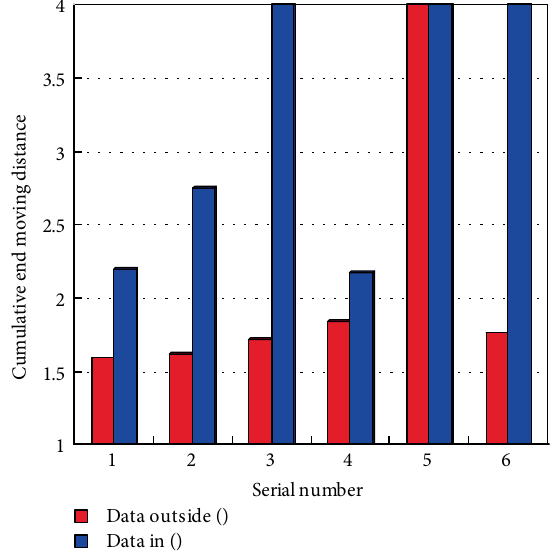
Figure 14: A comparison chart of Δ𝑋 sum when there are 3 or more obstacles.